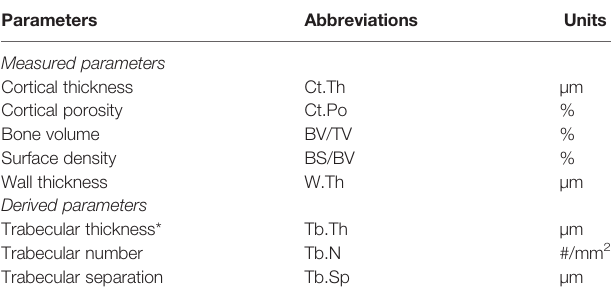
TABLE 3 | Histomorphometric parameters of bone structure and